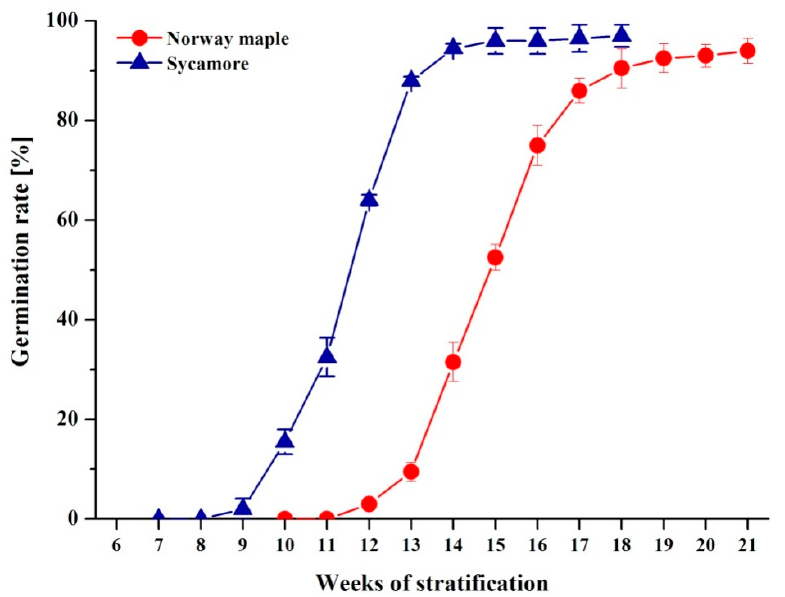
Figure 1. Germination curves representing Norway maple and sycamore seeds subjected to germination. Data are the means of four independent replicates ± the standard deviation.